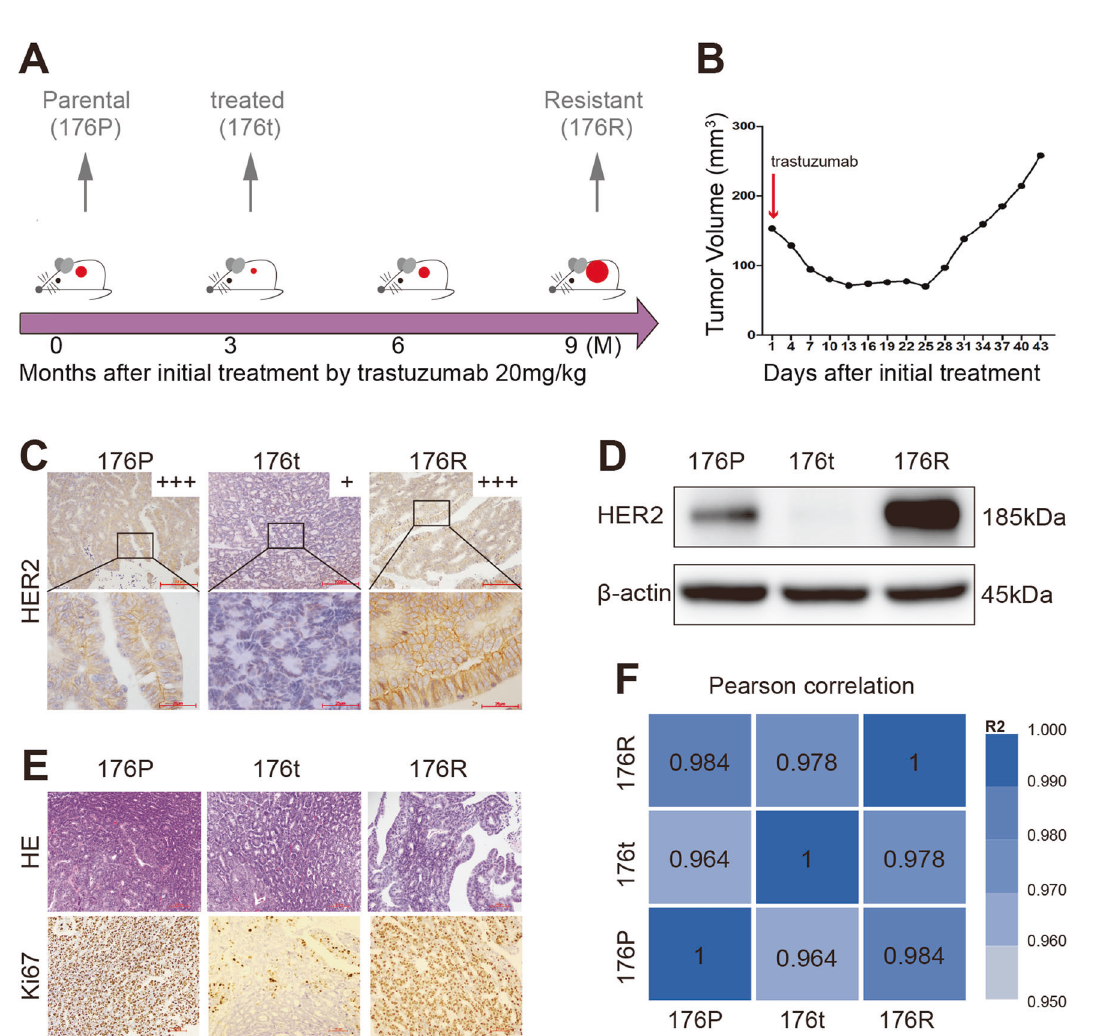
Fig. 1 Establishment and identi fi cation of Trastuzumab acquired resistant PDX model in gastric cancer. A The establishment procedure of Trastuzumab acquired resistant PDX model. The mice of 176P were exposed to Trastuzumab at the dose of 20 mg/kg for about 9 months